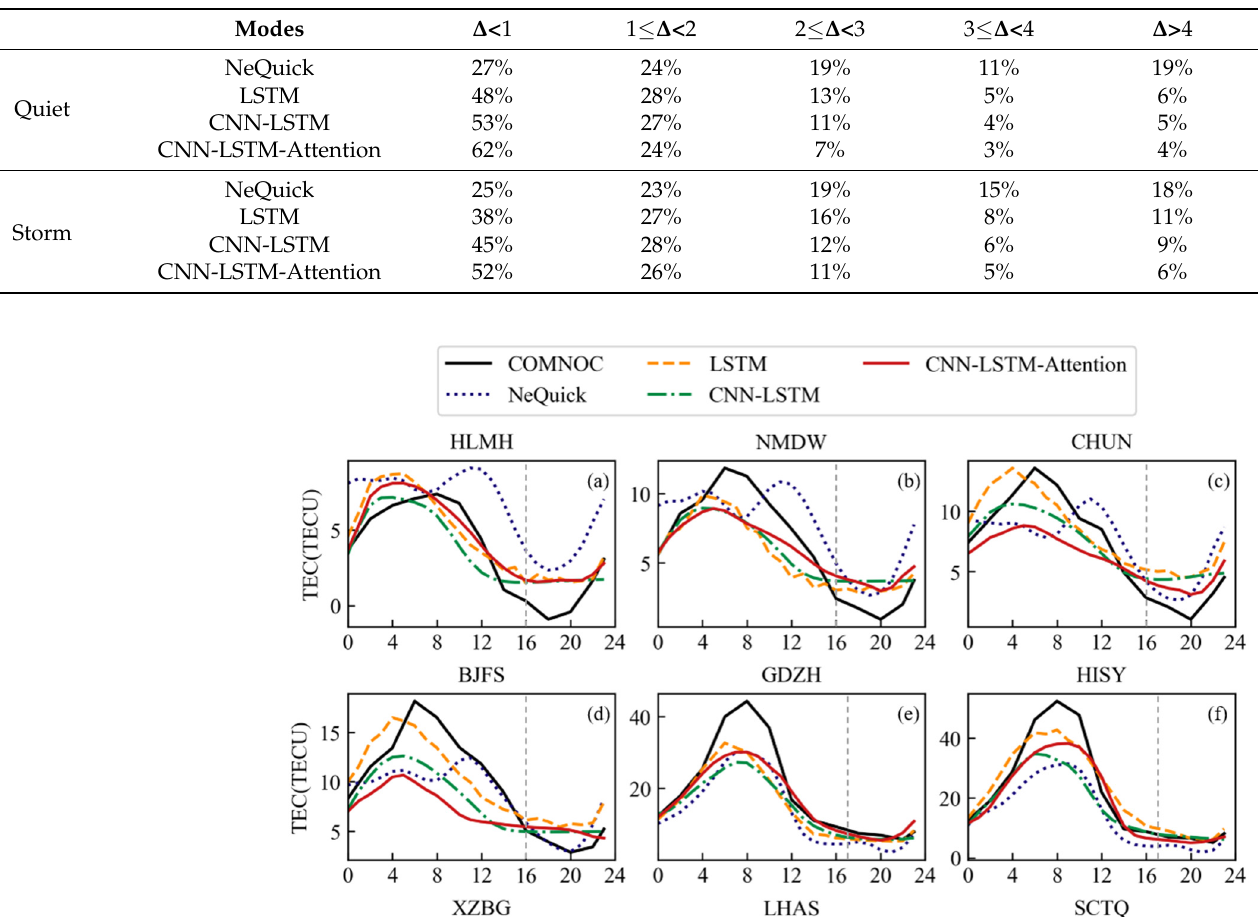
Table 4. Residual percentage statistics of 24 stations and 4 models in the test set.